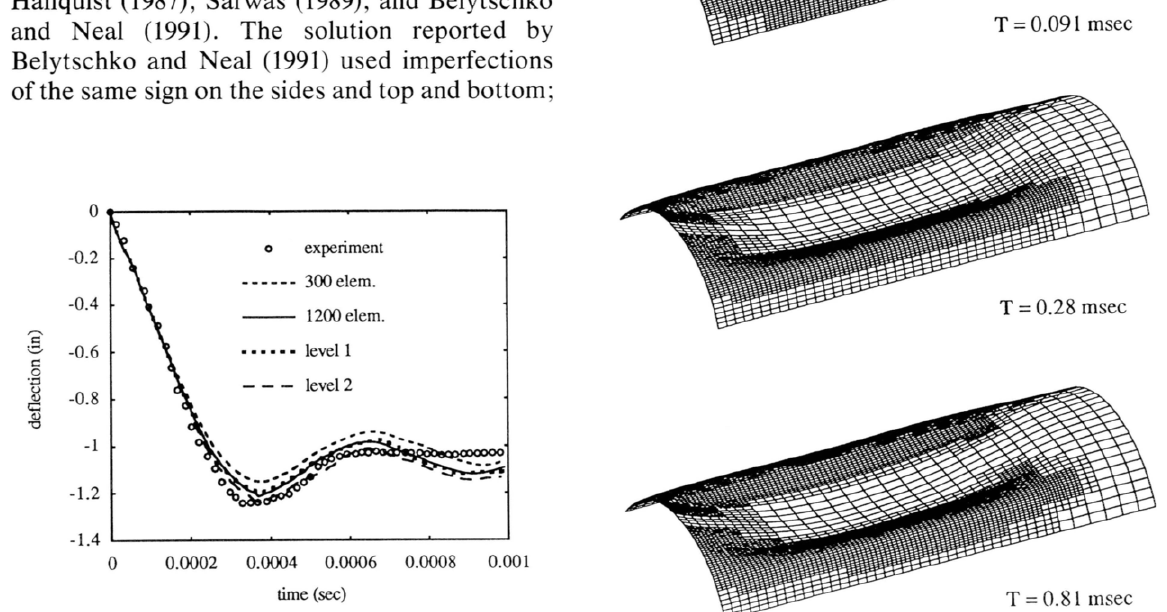
FIGURE 4 Deflections at the center of cylindrical panel. FIGURE 5 Deformed shapes of cylindrical